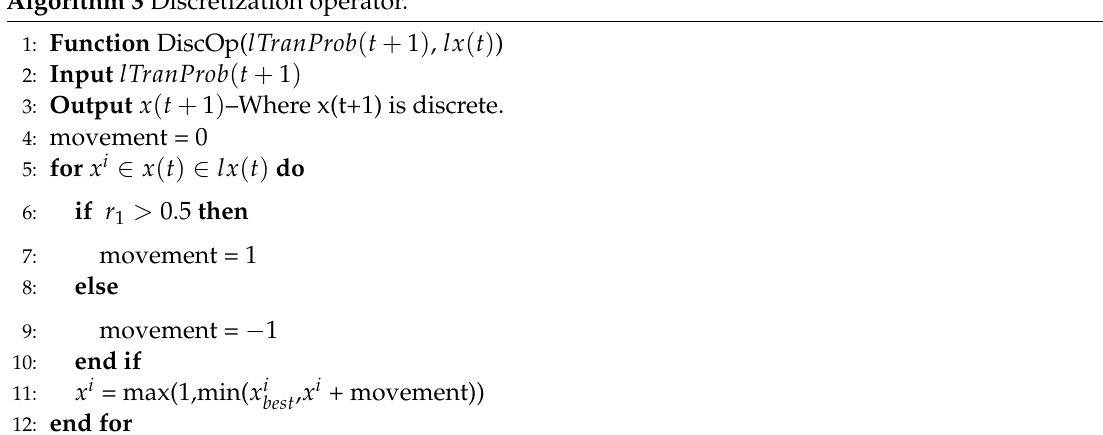
Algorithm 3 Discretization